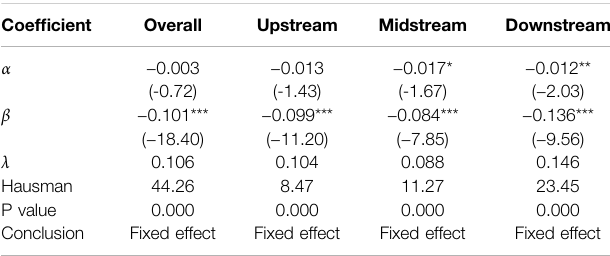
TABLE 4 | Absolute β test of ecological ef fi ciency of the Yellow River